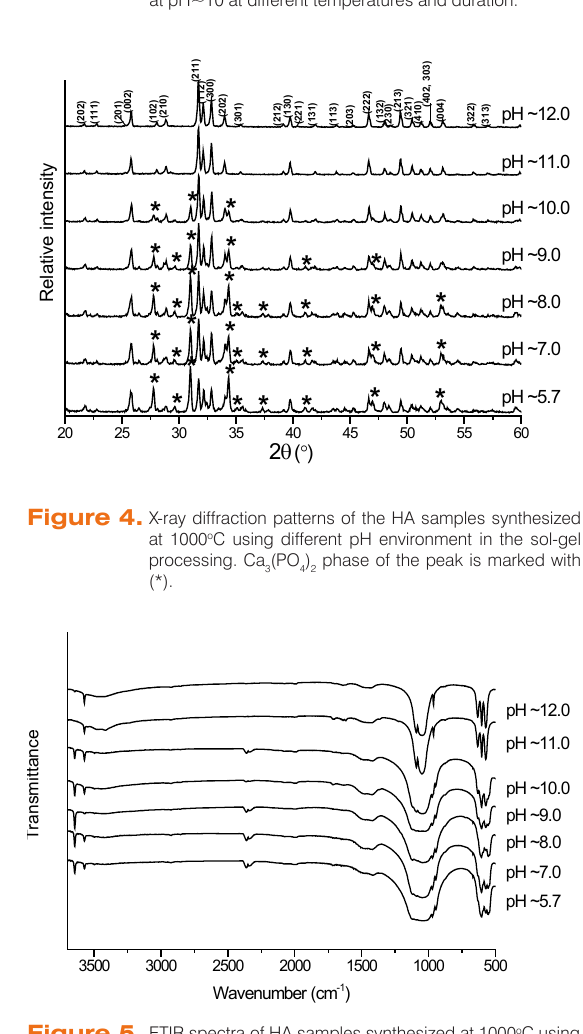
Figure 5. FTIR spectra of HA samples synthesized at 1000 o C using different pH environment in the sol-gel